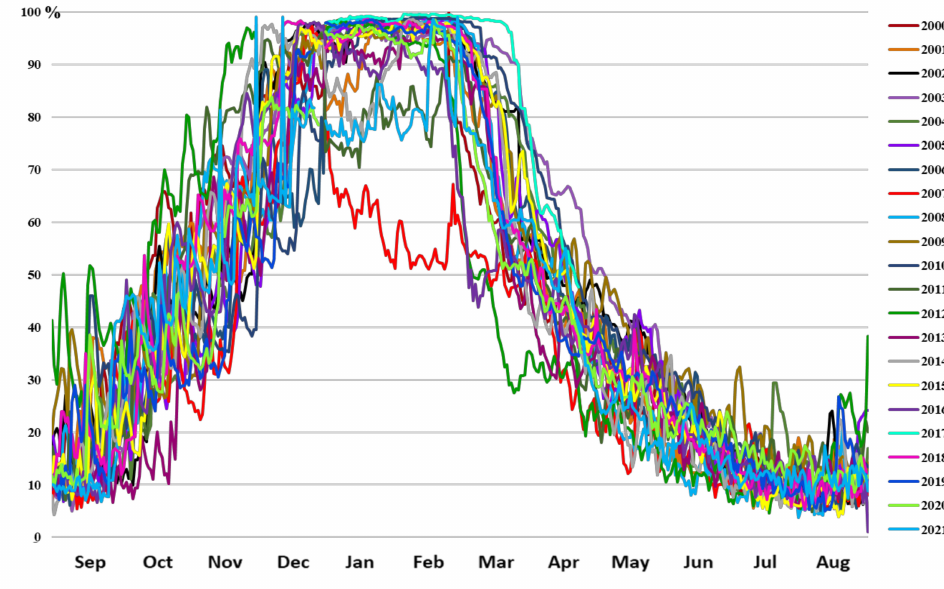
Figure 3. The evolution of daily snow covers the hydrological year 2000 to